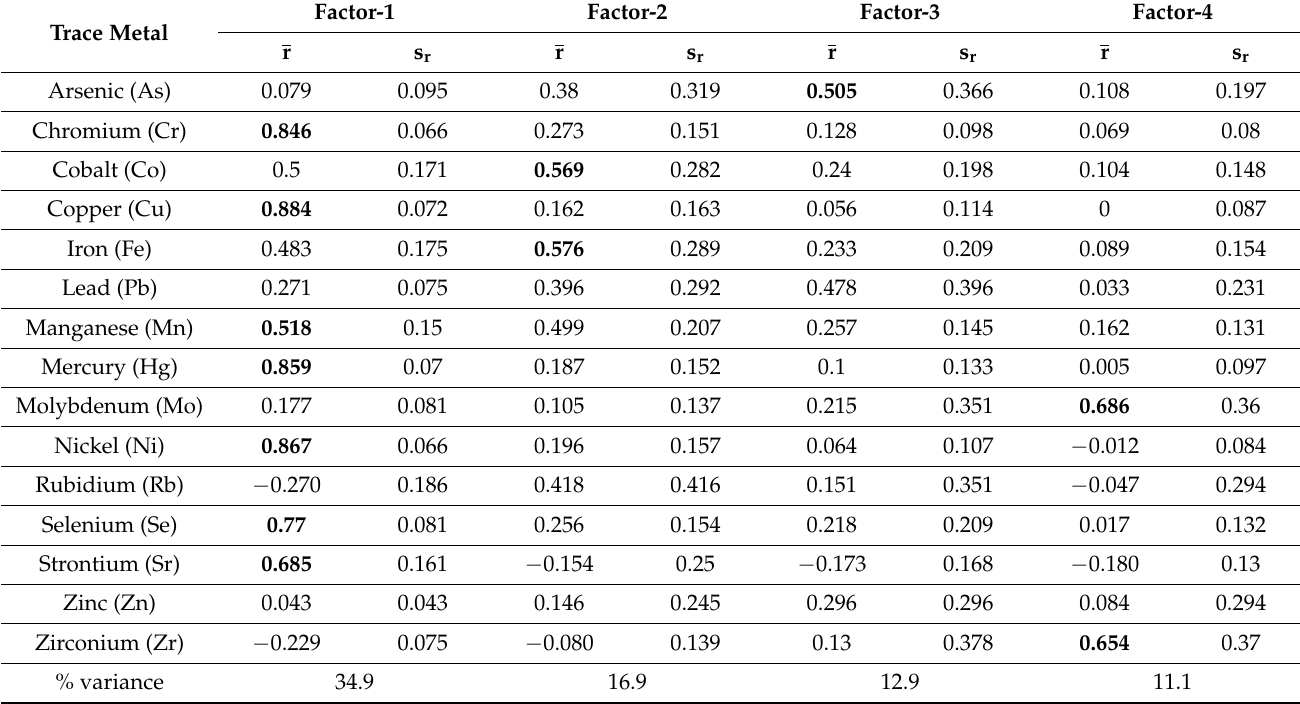
Table 7. Syracuse trace metal induced gamma distributed measurement error varimax-rotated factor dimensions: census tract averaged soil sample data (10,000